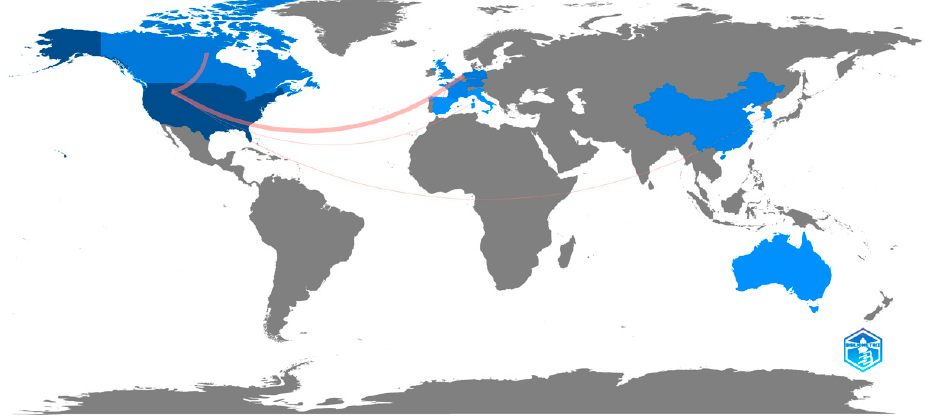
Figure 3. Country scientific production.